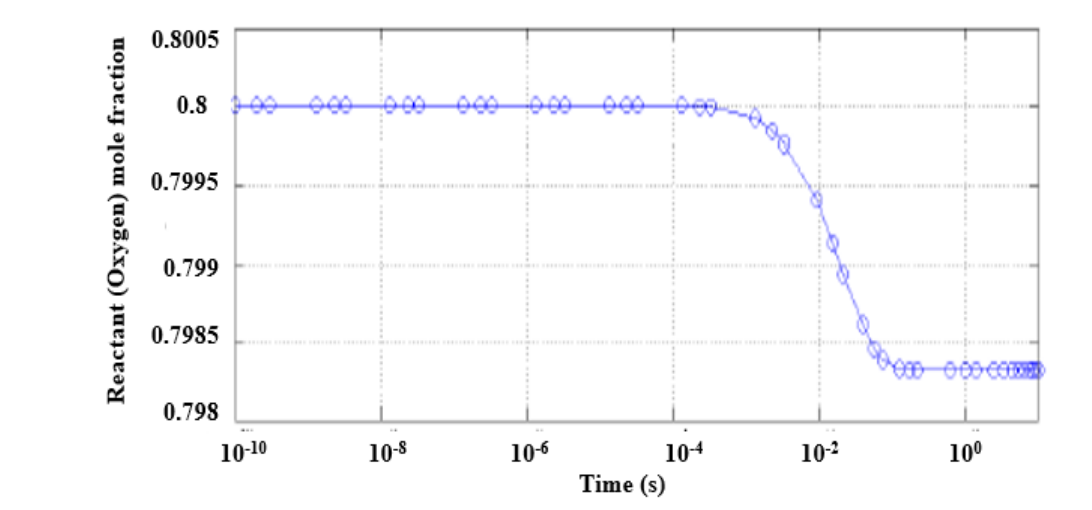
Figure 4. One-dimensional Plot of GDL reactant (oxygen) concentration.